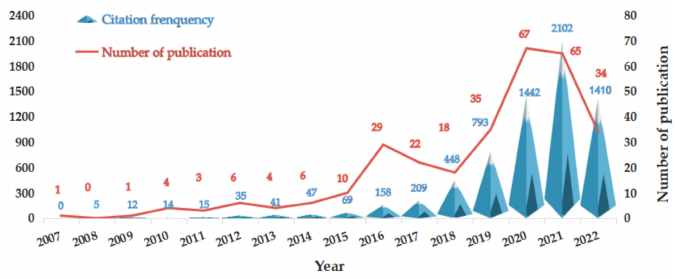
Figure 2. Time distribution of number of publication and citation frequency from 2007 to